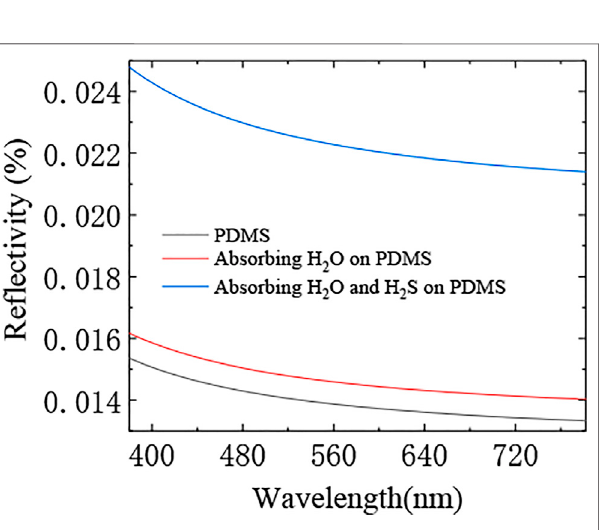
Frontiers in Materials |